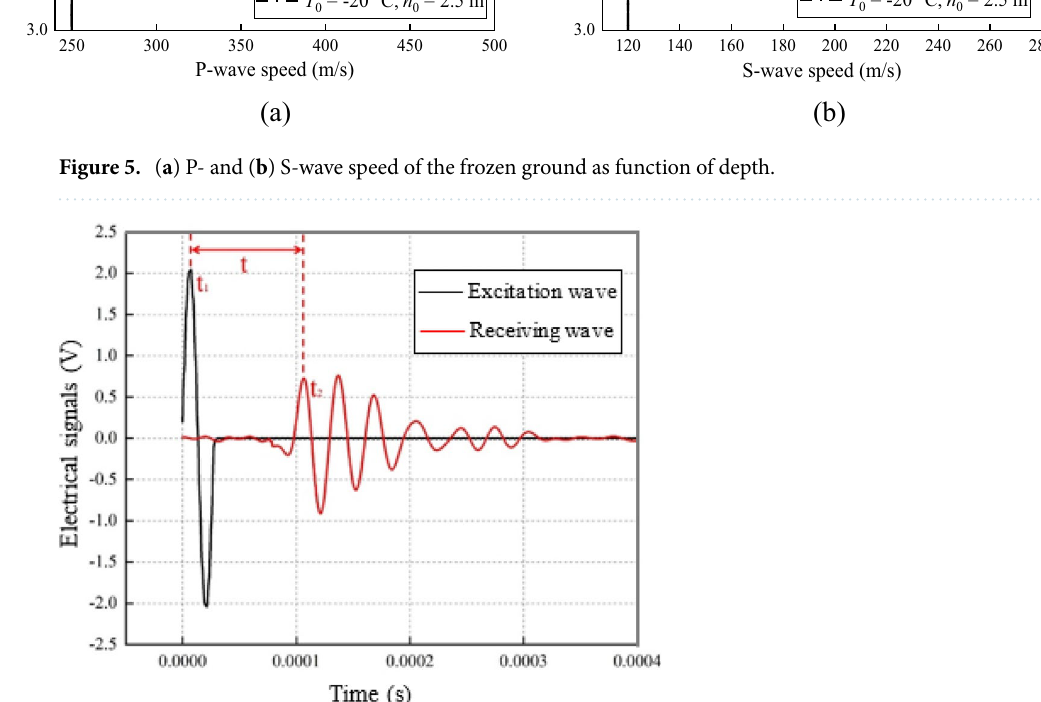
Figure 6. Determination of shear wave propagation